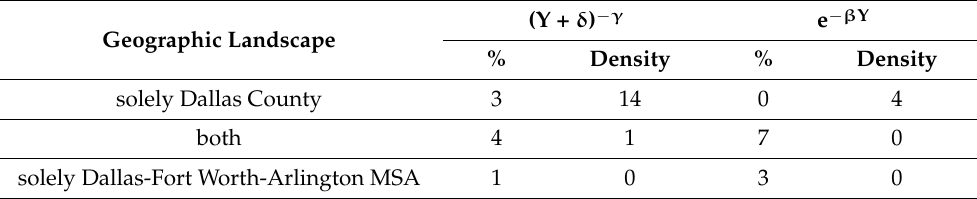
Table 1. Attribute counts for which reciprocal Box–Cox power (i.e., inverse polynomial) and Manly exponential transformations maximize the Shapiro–Wilk [16] normality diagnostic statistic † . (Y + δ ) − γ e − β Y Geographic Landscape % Density % Density solely Dallas County 3 14 0 both 4 1 7